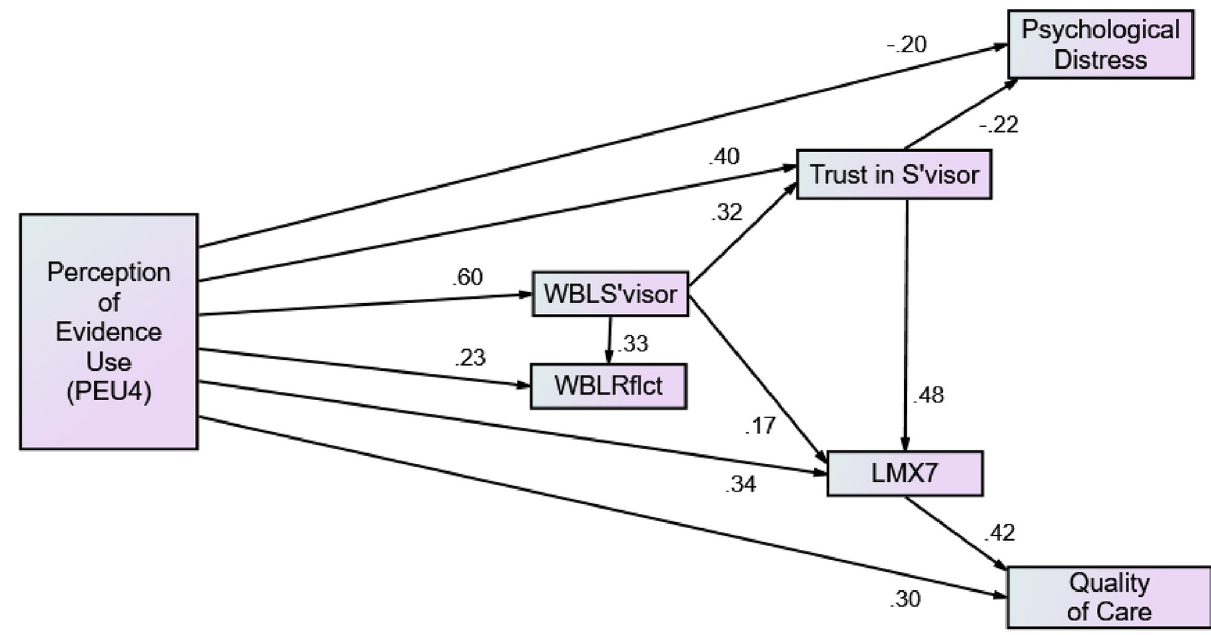
Fig 1. Results of hypothesized model.